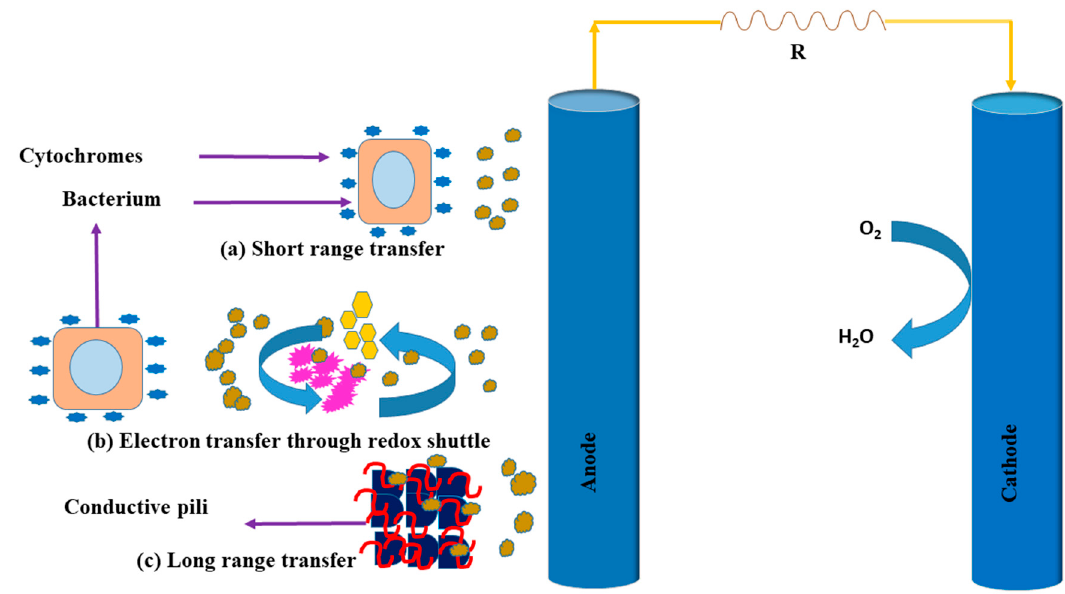
Figure 5. Bio-generation mechanism of electrons through microbes to electrodes: ( a ) short range electron transfer via cytochromes, ( b ) electron transfer via redox shuttles, ( c ) long range transfer via conductive pili, and (R) Resistance. 435